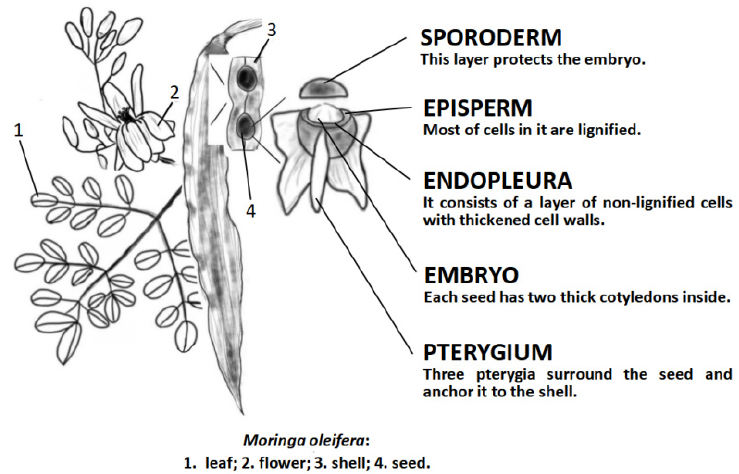
Figure 1. Schematics of Moringa oleifera representative body parts.